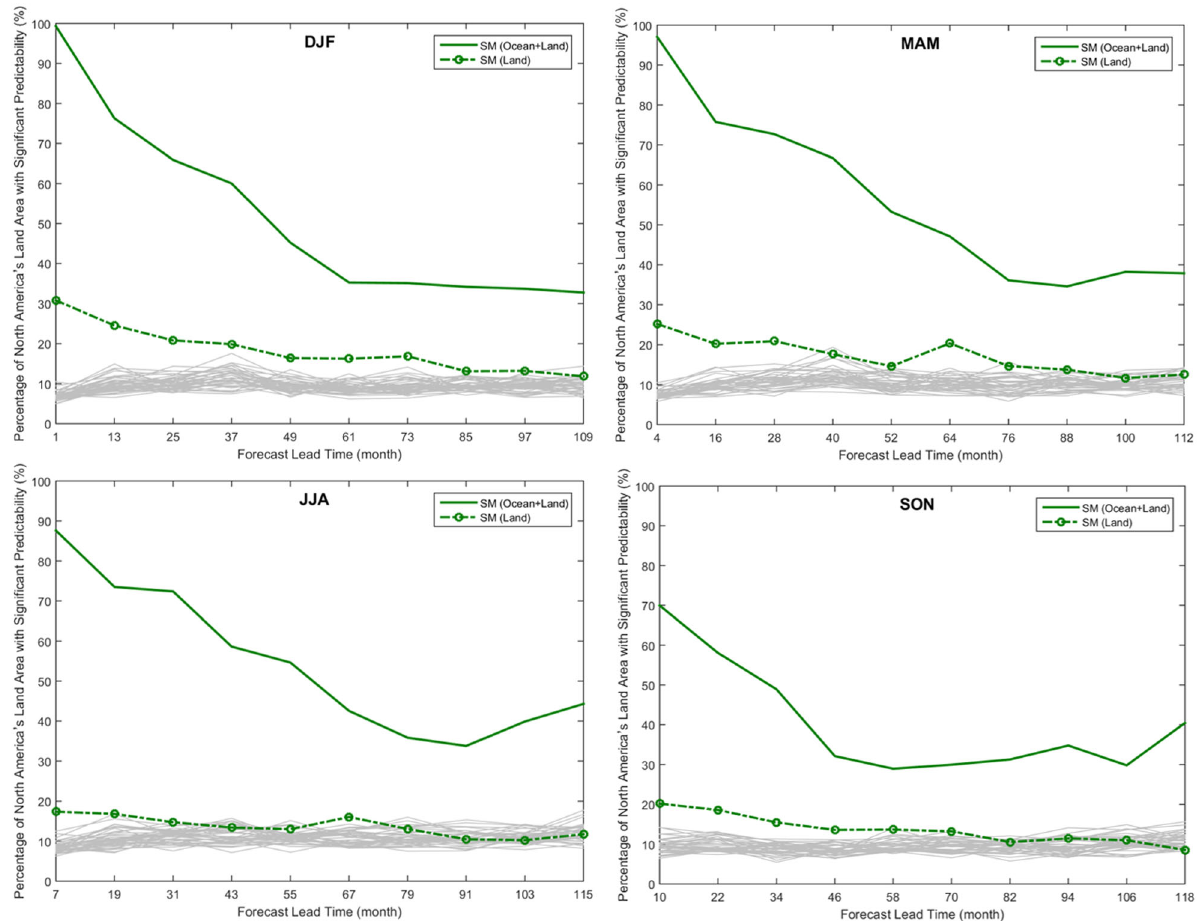
Fig. 3 Comparison of the total soil moisture predictability area in North America due to ocean and land initialization effects (Ocean + Land) with that due to land-only initialization effect (Land). Thin gray lines show the expected statistical distribution if the land-only were not initialized. We determined the land-only effects by computing the anomaly correlations between initialized total soil moisture anomalies and the ensemble average forecast anomalies for the root zone soil moisture. Thin gray lines are obtained by correlating the uninitialized soil moisture initial condition (remaining 39 LE initial conditions) with the ensemble average DPLE